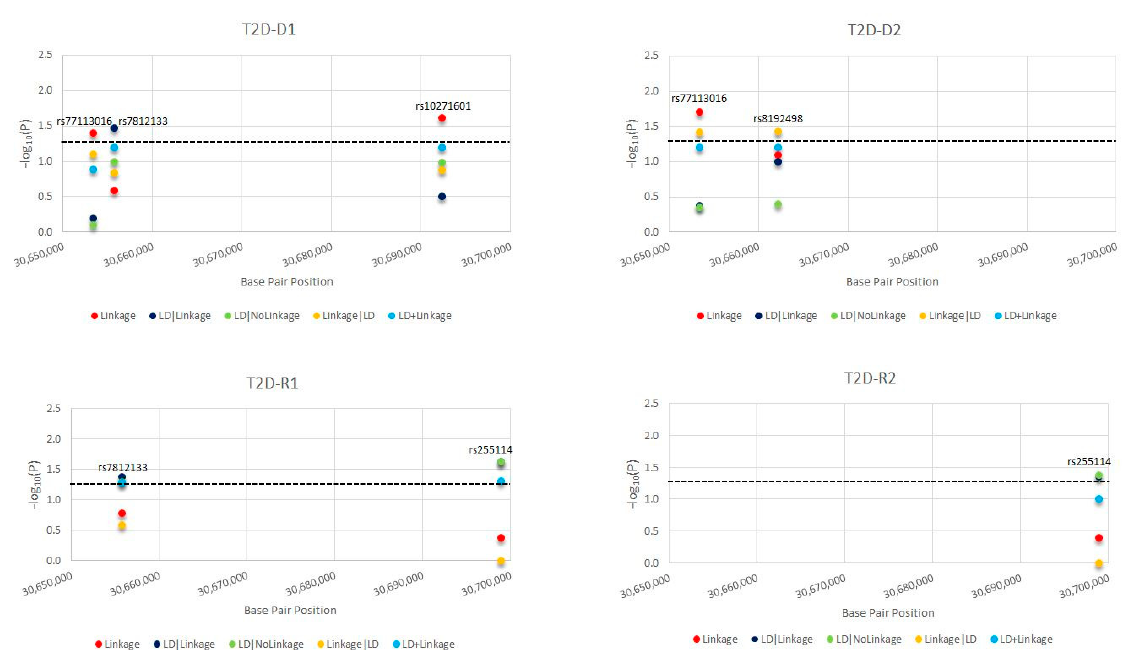
Figure 2. Type 2 Diabetes (T2D) CRHR2 -Risk Single Nucleotide Polymorphisms (SNPs). For each CRHR2 -risk SNPs in T2D, we present the − log 10 (P) as a function of each test statistic [Linkage,